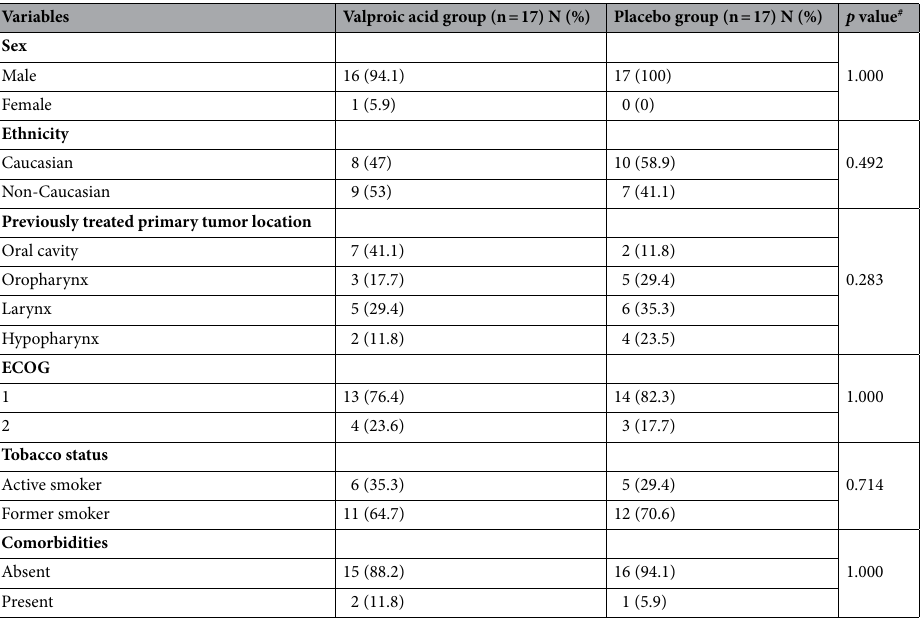
Table 1. Sociodemographic and clinical characteristics of the study population (n = 34). ECOG Eastern Cooperative Oncologic Groups. # Calculated by Fisher’s exact test except for tobacco status and ethnicity, which were calculated by the chi-square